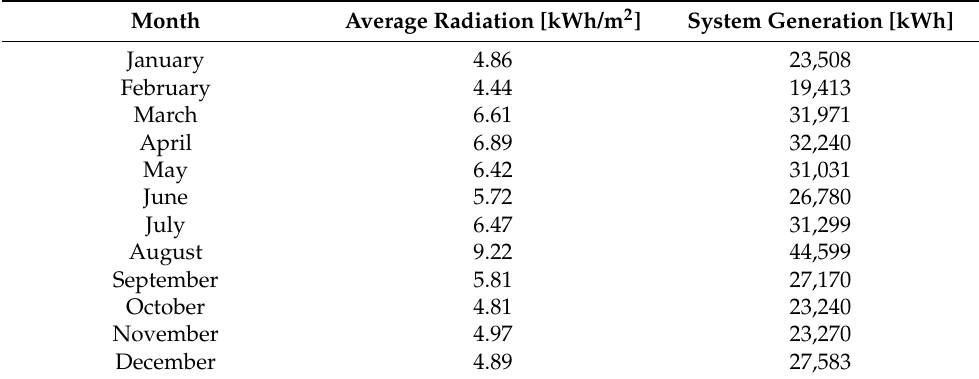
Table 5. Monthly solar radiation and power generation from the solar-based system.